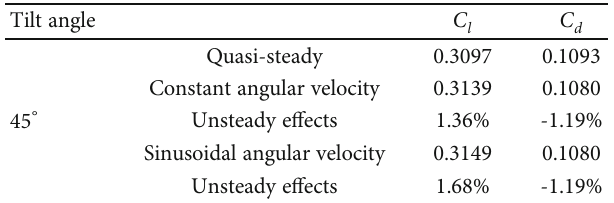
Table 3: Quantitative comparisons of the aerodynamic coe ffi cients in 3D